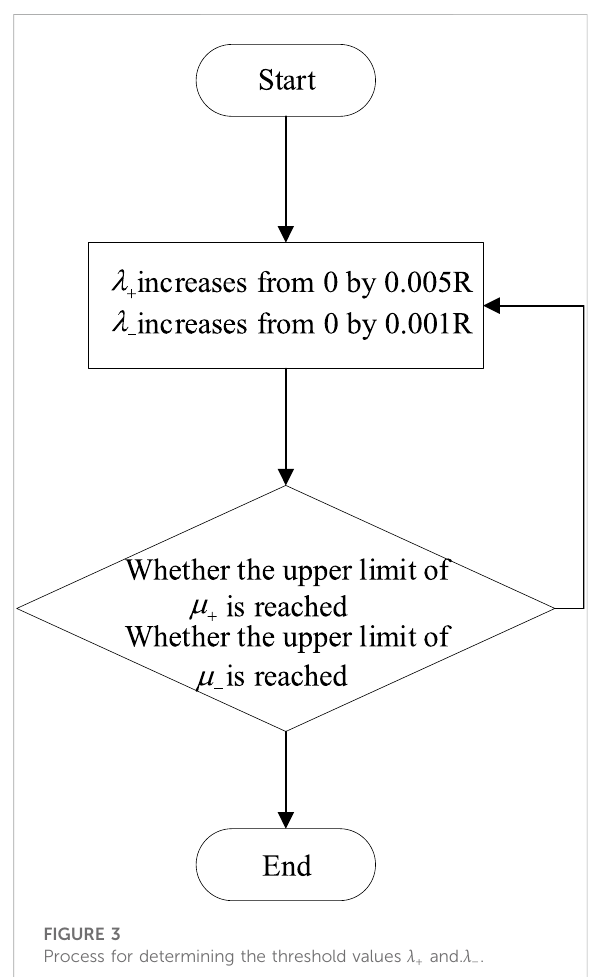
FIGURE 3 Process for determining the threshold values λ + and. λ −